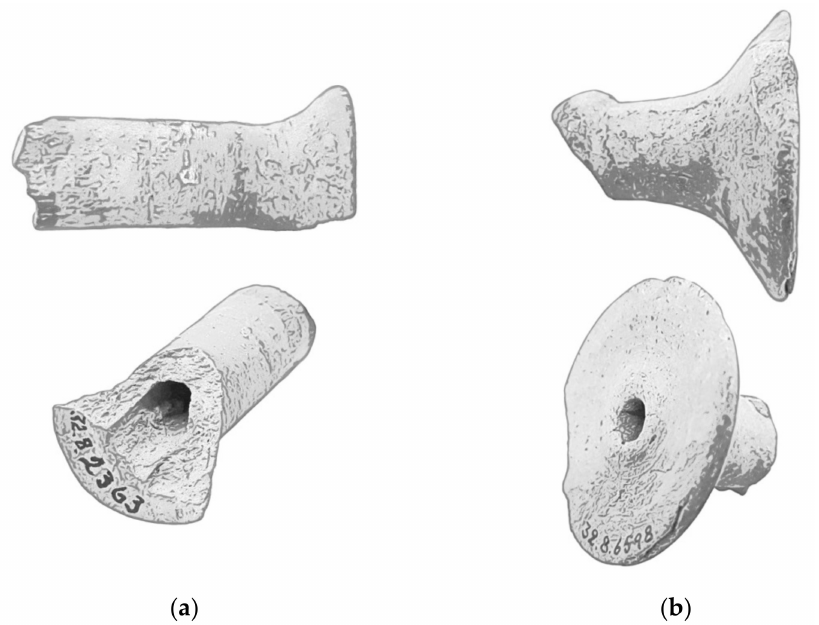
Figure 3. Possible discoidal shell horn mouthpieces from ceramics excavated by Sigvald Linn é in Teotihuacan: ( a ) EmS (Inv. 32.08.2363), fragment, possibly Mayan, length: 4.4 cm; ( b ) EmS (Inv. 32.08.6598), fragment, length: 3.6